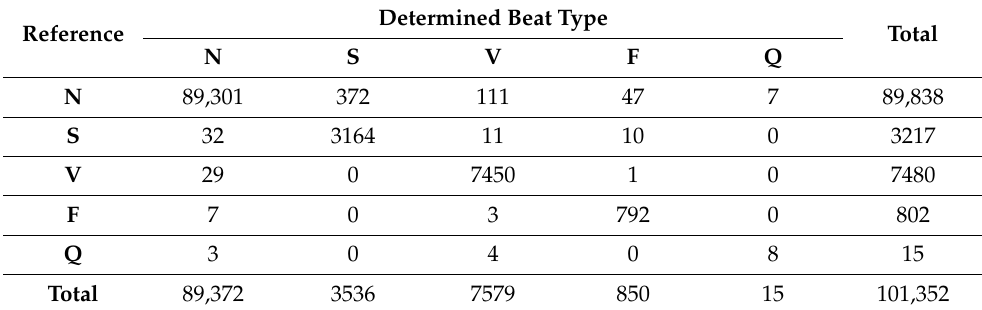
Table 5 displays the confusion matrix for the ANSI/AAMI EC57:1998 standard beat labels. Table 5. Confusion matrix for beat classification using AAMI beat labels (with nECG MITDB records).